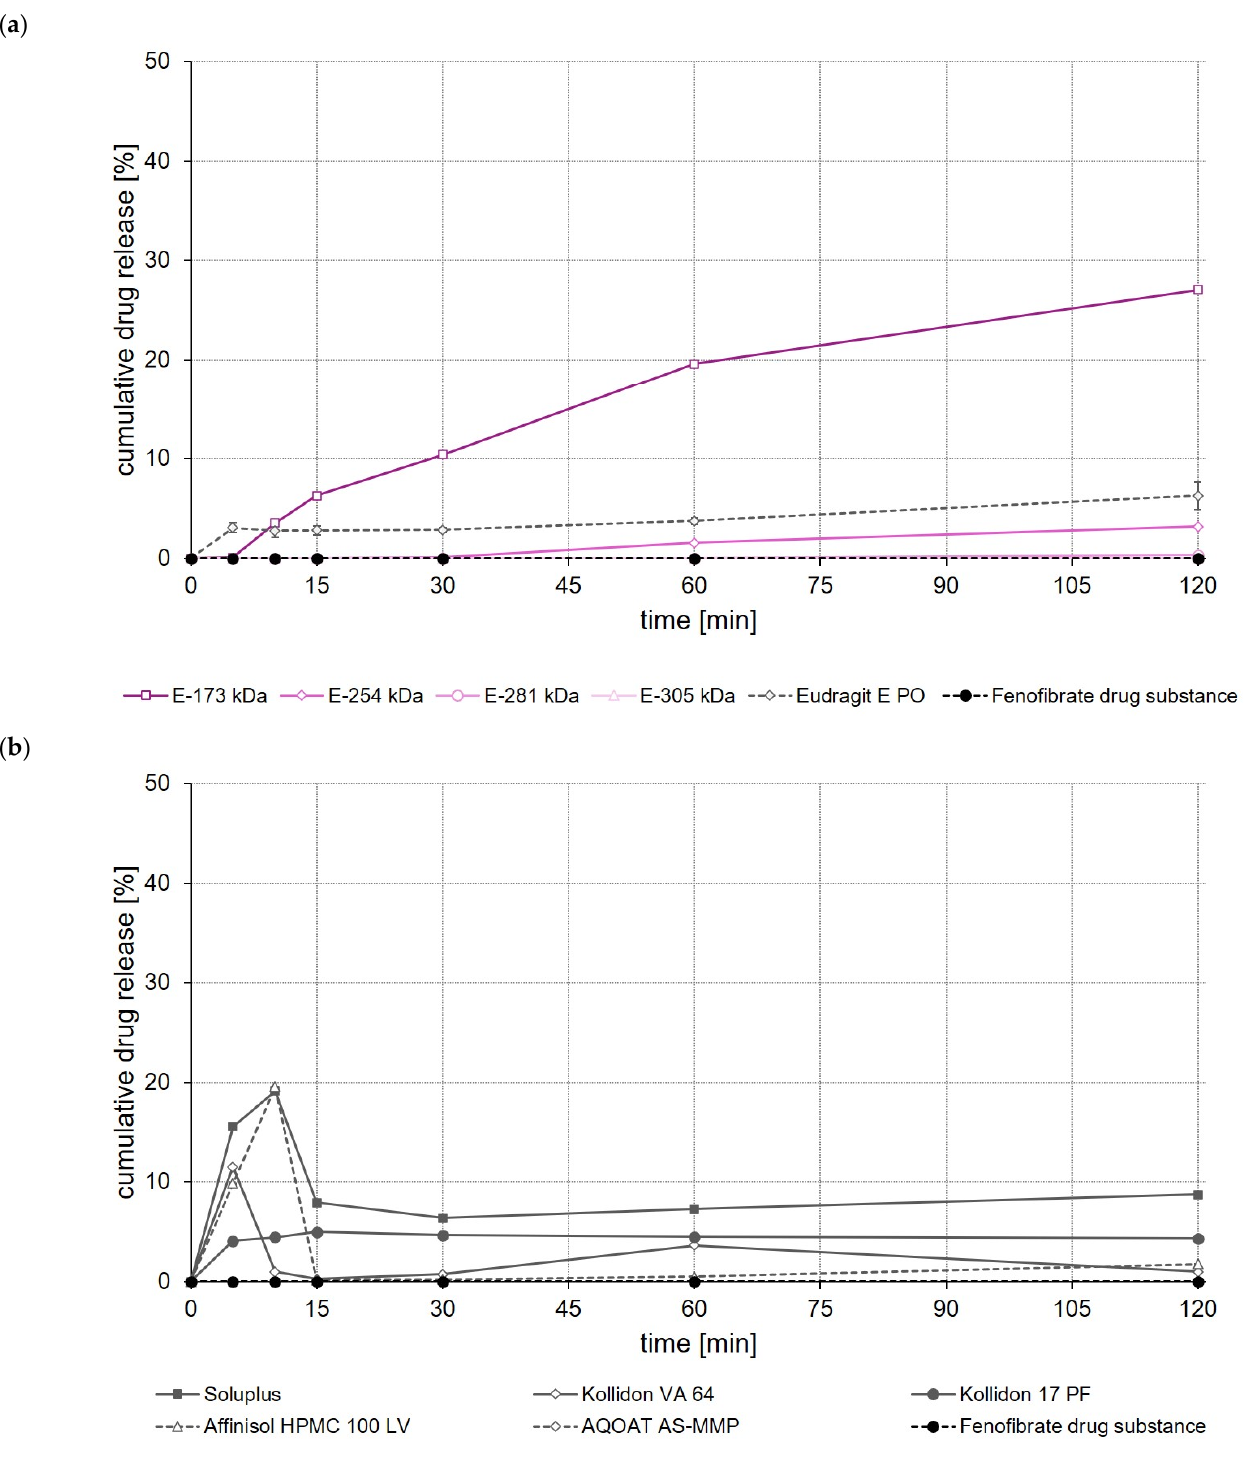
Figure 11. Dissolution profiles of fenofibrate drug substance and fenofibrate ASDs based on ModE and EPO ( a ), as well as fenofibrate drug substance and fenofibrate ASDs based on other marketed (co-)polymers ( b ) (after three months of storage at 30 °C/65% RH) in 500 mL 0.1 M HCl in USP apparatus II. Each value designates the mean ± S.D. (n = 3).